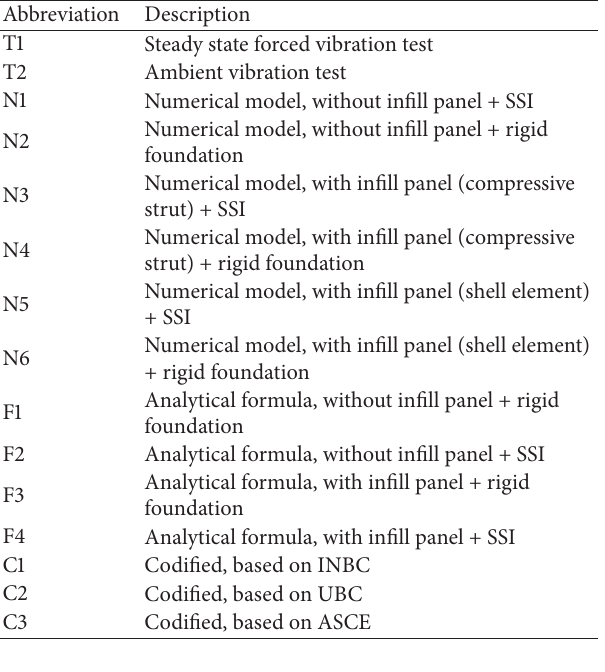
Table 3: Different methods/models for frequency analysis.